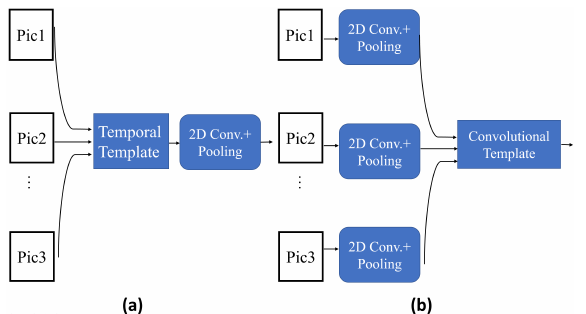
Figure 3. Deep gait recognition architectures.